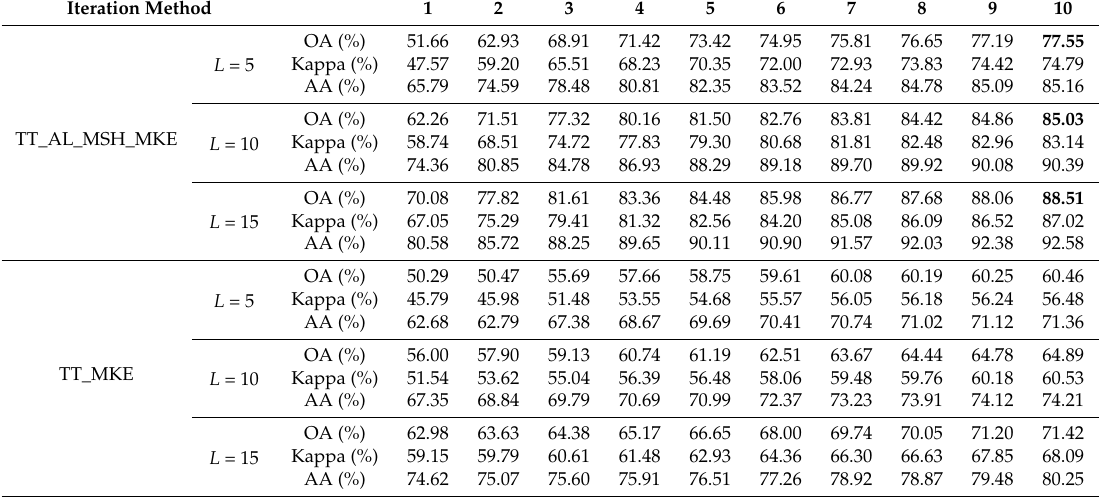
Table 5. Overall accuracy using two different techniques for the AVIRIS Indian Pines data, with 5, 10 and 15 initial training samples per class. The best OA results of each table are marked in bold italics. Iteration